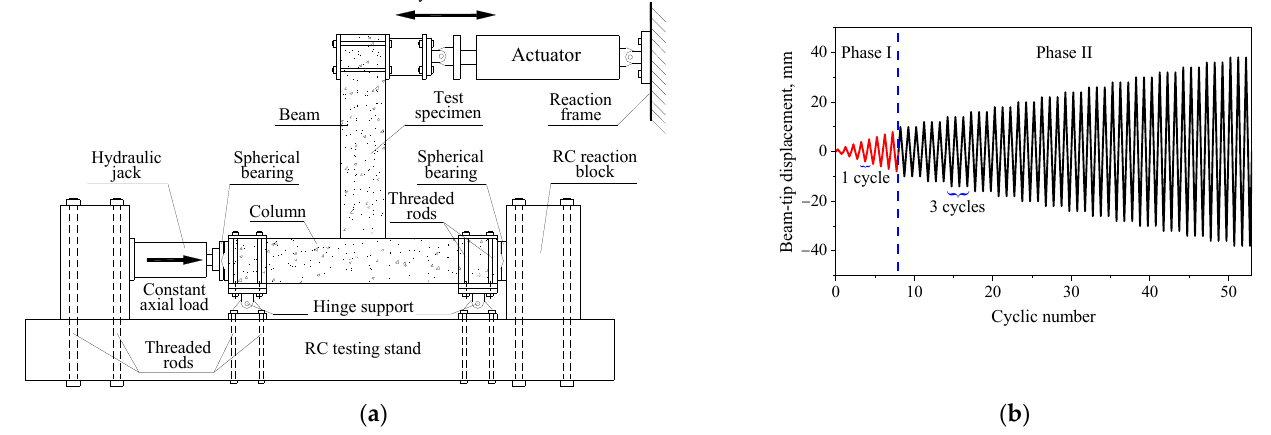
Figure 2. Test method. ( a ) Test setup; ( b ) Displacement history of cyclic loading.